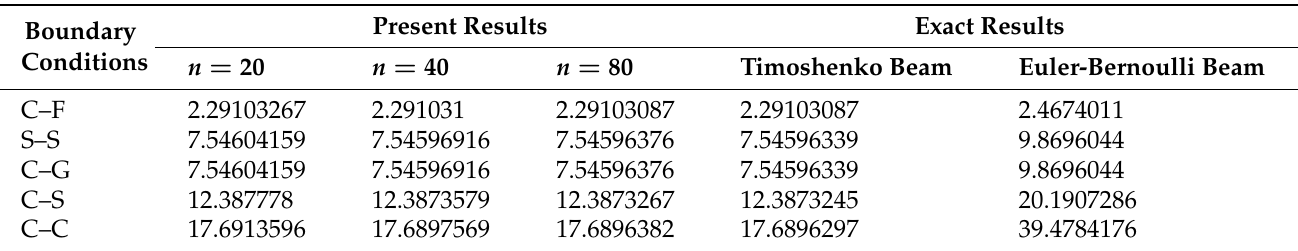
Table 7. Dimensionless critical load of a uniform Timoshenko beam with different boundary conditions.